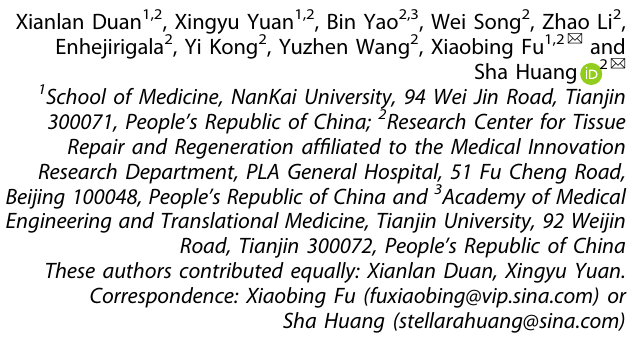
Fig. 1 The role and mechanism of CTHRC1 in promoting cutaneous wound healing. a The relative expression values of Cthrc1 mRNA during skin wound healing time course (0 d, 1 d, 3 d, 5 d, 7 d, and 10 d) were extracted from the existing RNA-seq gene expression dataset (GSE23006). N = 3 for each time-point. b Immuno fl uorescent staining for CTHRC1 from d 0 to d 10 post-wounding (CTHRC1, red; 4 ′ ,6- diamidino-2-phenylindole (DAPI), blue; scale bar, 100 μ m). c Cthrc1 mRNA expression was quanti fi ed in dermal tissues of the wound from 0 to 10 days post wounding using quantitative PCR. Values are given as mean ± SD. N = 3 for each time-point. d The CTHRC1 content of skin wound tissues was quanti fi ed by ELISA and normalized to the total protein concentration. N = 4 for each time-point. e Wounds were photographed at 1, 3, 5, and 7 days after wounding from 4 Cthrc1 − / − and 6 WT mice (Wt). f Quanti fi cation of wound area was from photographs. Cthrc1 − / − wounds are delayed in closure at day 7. Data are expressed as the percentage of the remaining area to the initial wound area. Values are given as mean ± SD. g Representative H&E stained sections of day 7 wounds from Cthrc1 − / − and WT mice. New epithelial tongue indicated by yellow lines (scale bar, 200 μ m). h Quanti fi cation of the length of the new epithelial tongue (as demarcated by the yellow lines in g ). Four sections were chosen for each group. Values are given as mean ± SD. i Immuno fl uorescence analysis of day 7 wounds from Cthrc1 − / − and WT mice. Sections were incubated with an antibody for α -SMA, TGF- β 1, COL1, and Arg1 ( α -SMA, green; TGF- β 1, COL1, and Arg1, red; DAPI, blue; scale bar, 200 μ m). j The top 20 GO term of the downregulated genes in the Cthrc1 − / − mice day 7 wounds compared to WT mice wounds by Metascape online tool. The color represents the enriched signi fi cance. k Left, representative images of the gap areas at 0, 24, 48, and 72 h after treating HaCaT cells with rh-CTHRC1 (100 ng/mL) in scratch wound healing assay (scale bar, 500 μ m). Right, quanti fi cation of the scratch wound areas. Data are expressed as the percentage of the remaining area to the initial scratch area. Values are given as mean ± SD. l Left, western blot analysis of lysates was carried out to quantify N-Cadherin protein level of HaCaT cells treated with rh-CTHRC1. Right, quanti fi cation of N-Cadherin protein levels relative to β -actin. Data are presented as mean ± SD, N = 4. m Representative images of the gap areas at 0, 12, and 24 h after treating mFbs and Cthrc1 − / − fi broblasts (CFbs) with rm-CTHRC1 (100 ng/mL) in scratch wound healing assay (scale bar, 500 μ m). n , o Quanti fi cation of the scratch wound areas. Data are expressed as the percentage of the remaining area to the initial scratch area. p Representative gel pictures at 0, 3, 6, and 9 d after the treatment of mFbs and CFbs with rm-CTHRC1 (100 ng/mL) in gel contraction assay. q , r Quanti fi cation of the gel areas. Data are expressed as the percentage of the remaining area to the initial gel area. s Left, western blot analysis of lysates was carried out to detect protein levels of mFbs treated with rm-CTHRC1. Right, quanti fi cation of α -SMA, and procollagen I protein levels relative to GAPDH, and pSmad2/3 protein levels relative to Smad2/3. Data are presented as mean ± SD, N = 3. t Representative images and quanti fi cation of migratory cells after treating RAW264.7 cells with rm-CTHRC1 (100 ng/mL) in Transwell migration assay (scale bar, 100 μ m). The number of migratory cells was measured from fi ve randomly selected fi elds. u Wounds were photographed at 1, 3, 5, and 7 days after wounding from 10 Cthrc1 − / − , 10 rm-CTHRC1-treated Cthrc1 − / − , and 8 WT mice. v Quanti fi cation of wound area was from photographs. Cthrc1 − / − wounds are delayed in closure at day 7, and rm-CTHRC1 recovered the wound healing rate. Data are expressed as the percentage of the closed area to the initial wound area. Values are given as mean ± SD. w Left, representative H&E stained sections of day 7 wounds from Cthrc1 − / − , rm-CTHRC1-treated Cthrc1 − / − , and WT mice (scale bar, 200 μ m). Right, quanti fi cation of the length of the new epithelial tongue (indicated by the yellow lines). x Immuno fl uorescence analysis of day 7 wounds from Cthrc1 − / − , rm- CTHRC1-treated Cthrc1 − / − , and WT mice (scale bar, 200 μ m). Sections were incubated with an antibody for α -SMA, COL1, MRC1, and